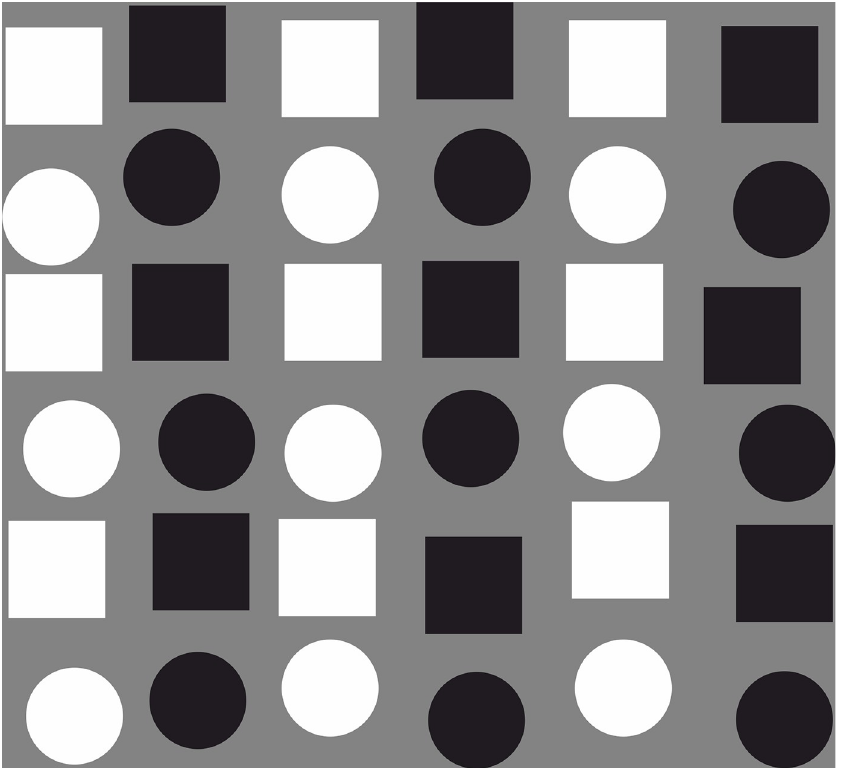
Fig 14. Demonstration of Gestalt